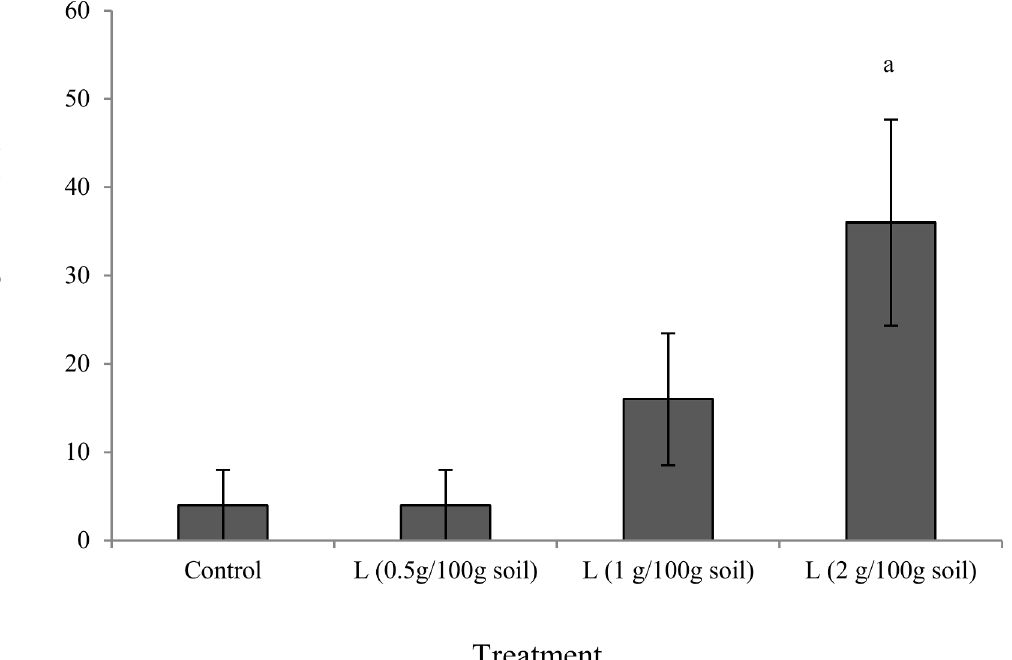
Fig 5. Number of X . bracteatum seedlings died due to phytotoxicity by boneseed litter-mediated soil. The x-axis denotes the treatment types (control and doses of boneseed litter (L)). Values on y-axis denote the number of X . bracteatum seedlings died after one week. The error bar indicates the standard error. The letter a indicates significant increase compared with control.